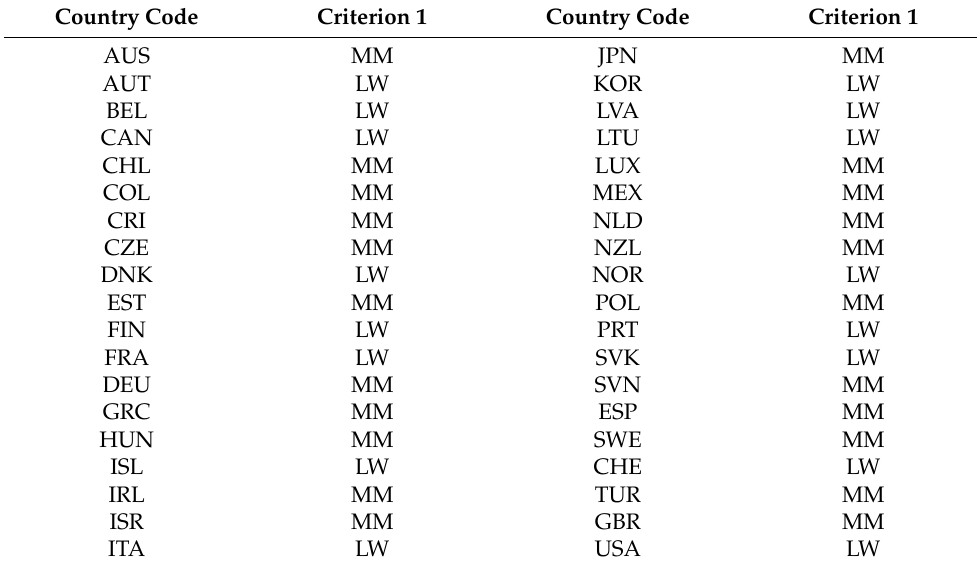
Table 11. First Type-1 FIS: Output increase level.